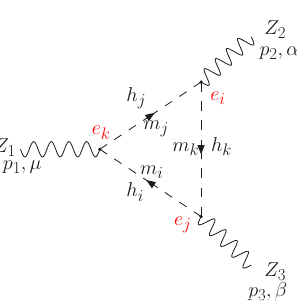
Figure 3. Feynman diagram contributing to the CP violating form factor f Z